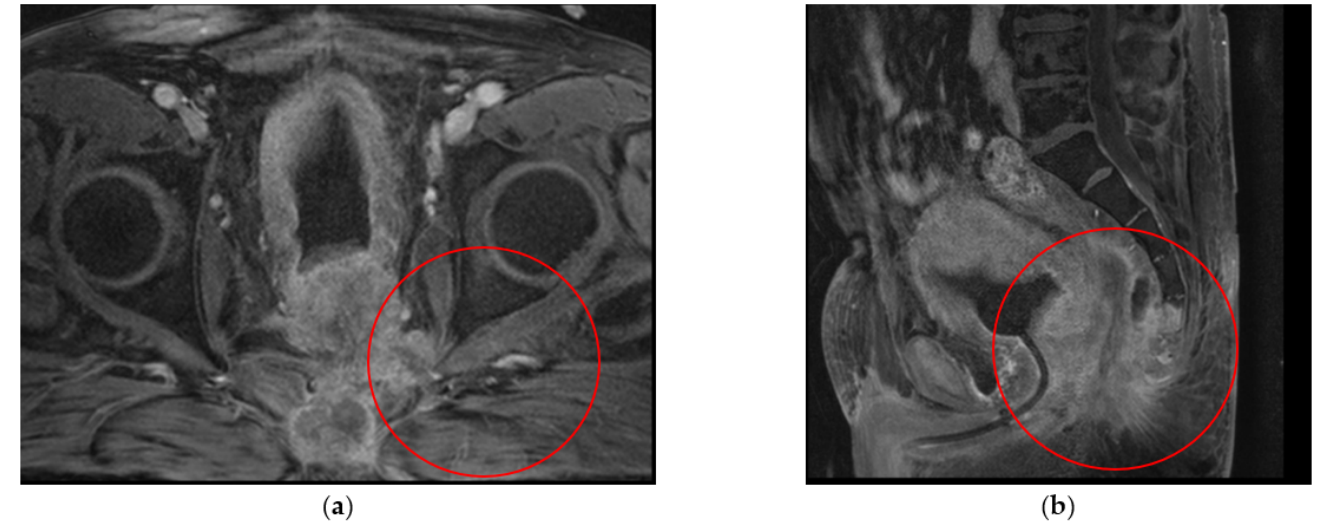
Figure 1. ( а ) MRI of the small pelvis with intravenous amplification—frontal projection; ( b ) MRI of the pelvis with intravenous enhancement—sagittal view (zone of tumor is circled).